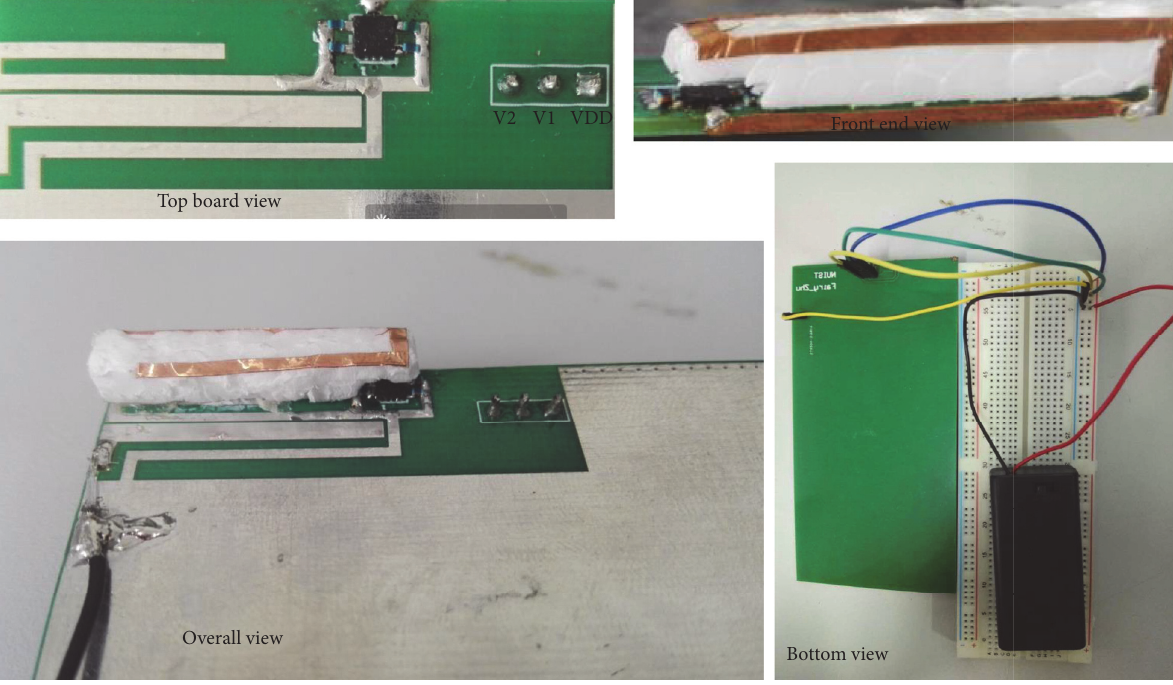
Figure 7: Photos of the fabricated